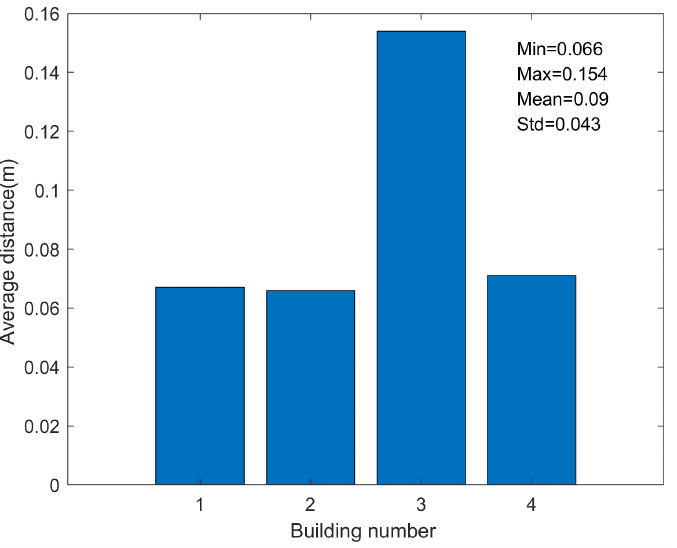
Figure 10. The statistical results of the reconstruction errors for four buildings.